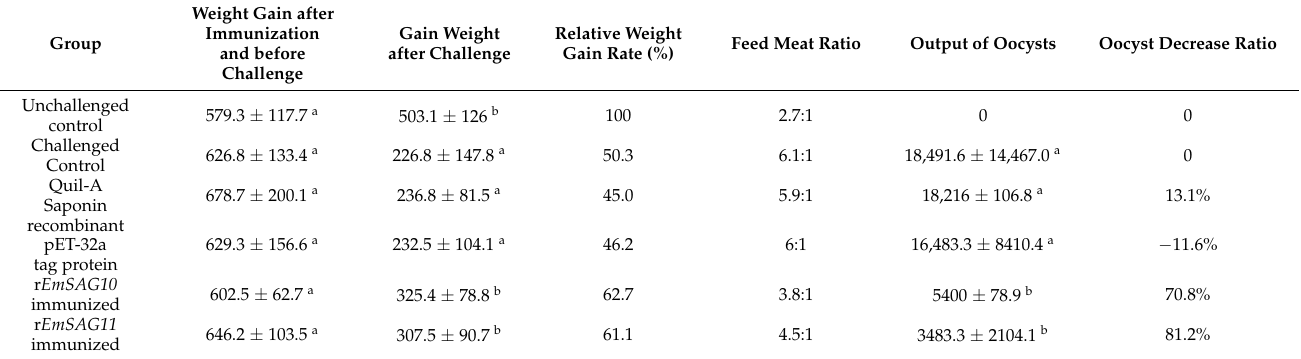
Table 2. Protective effects of r EmSAG10 and r EmSAG11 against an E. magna infection under different evaluation indicators.